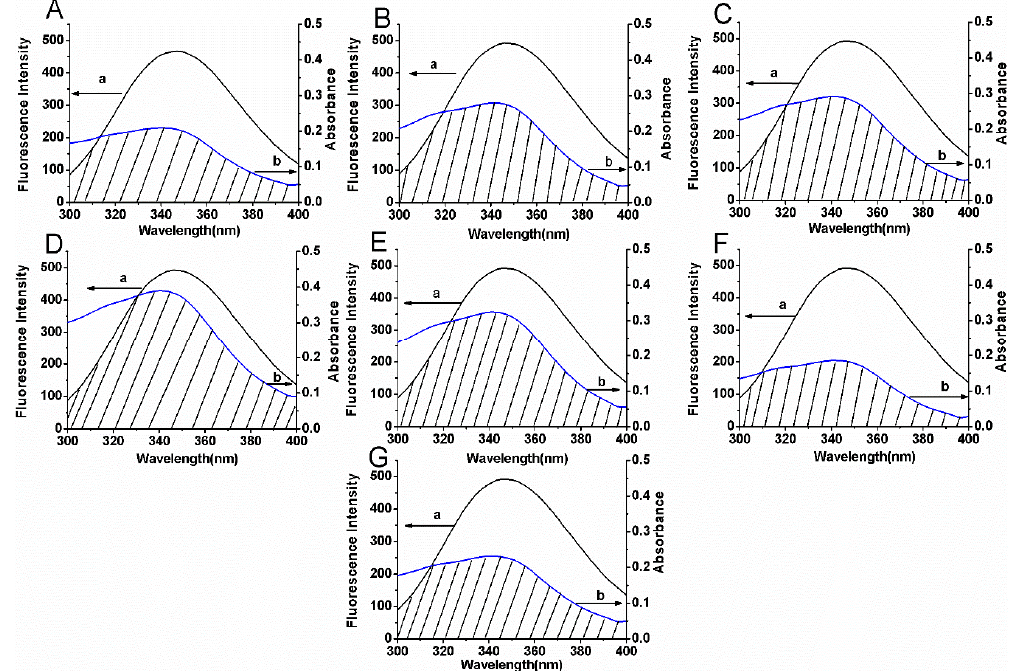
Figure 9. Spectral overlaps between the fluorescence spectra (a) of BSA and the absorption spectra (b) of compounds 1 ( A ), 2 ( B ), 3 ( C ), 4 ( D ), 5 ( E ), 6 ( F ) and 7 ( G ) in 0.05 mol L − 1 Tris-HCl, pH 7.4.The concentrations of BSA and compounds are 5 μ M and 30 μ M, respectively.